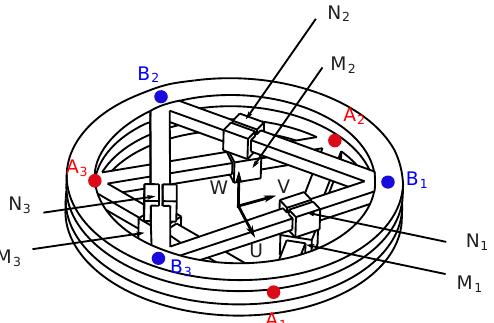
Figure 3. 3-PRP parallel